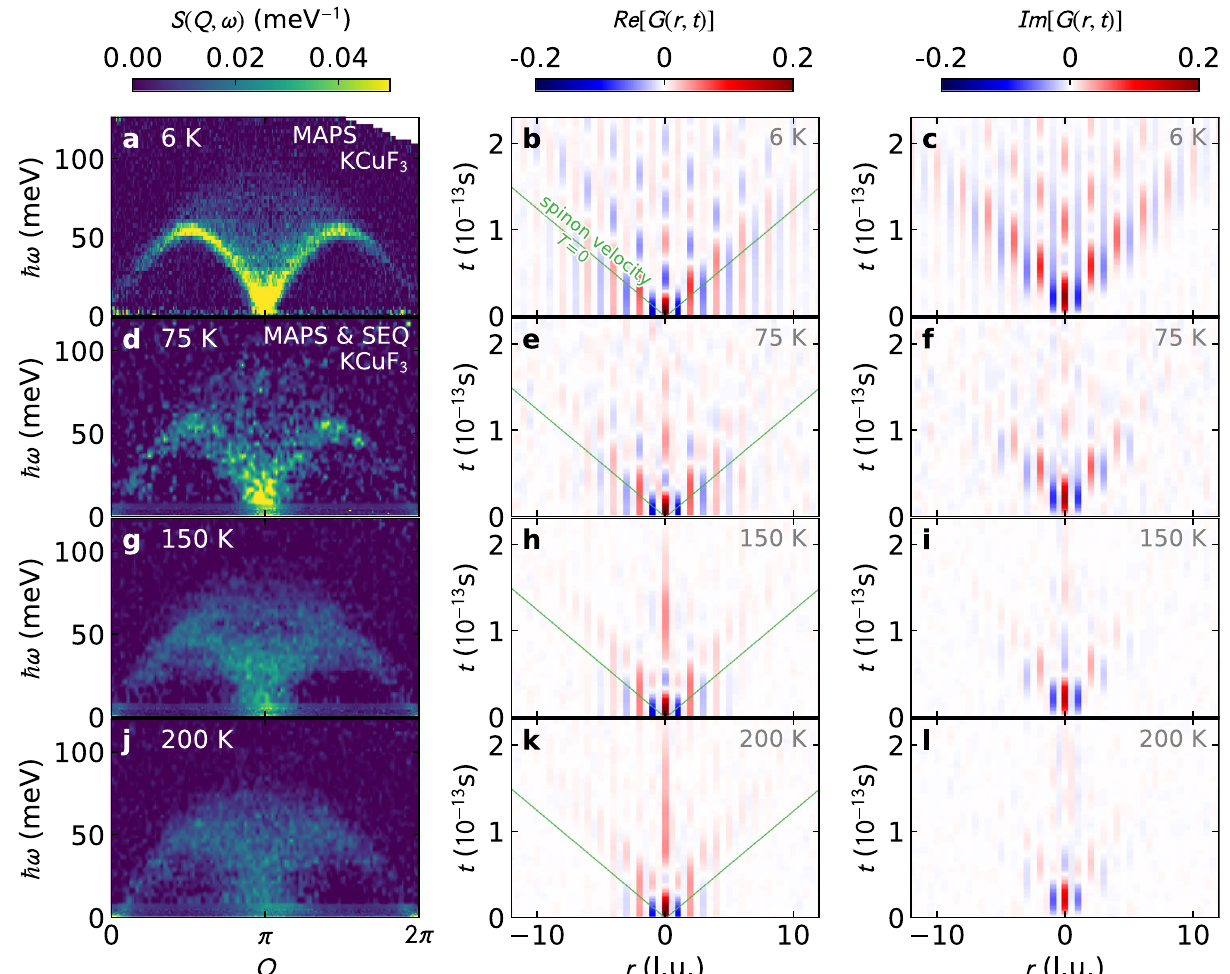
Fig. 1 | Scattering and Van Hove correlations. Finite temperature neutron scat- teringdataforKCuF 3 fromtheMAPSandSEQUOIA(SEQ)instruments(leftcolumn: a , d , g , j ) and their transformation to real-space correlations, with the real G ( r , t ) (centercolumn: b , e , h , k )andimaginary G ( r , t )(rightcolumn: c , f , i , l ).Redindicates ferromagnetic spin correlation, blue indicates antiferromagnetic spin correlation.